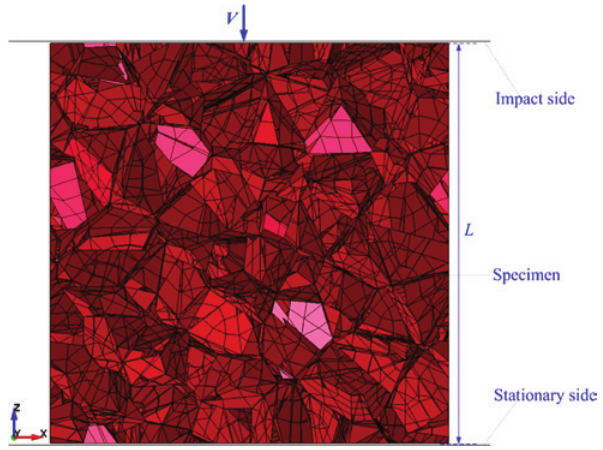
Figure 1: Illustration of the FE model with loading conditions.